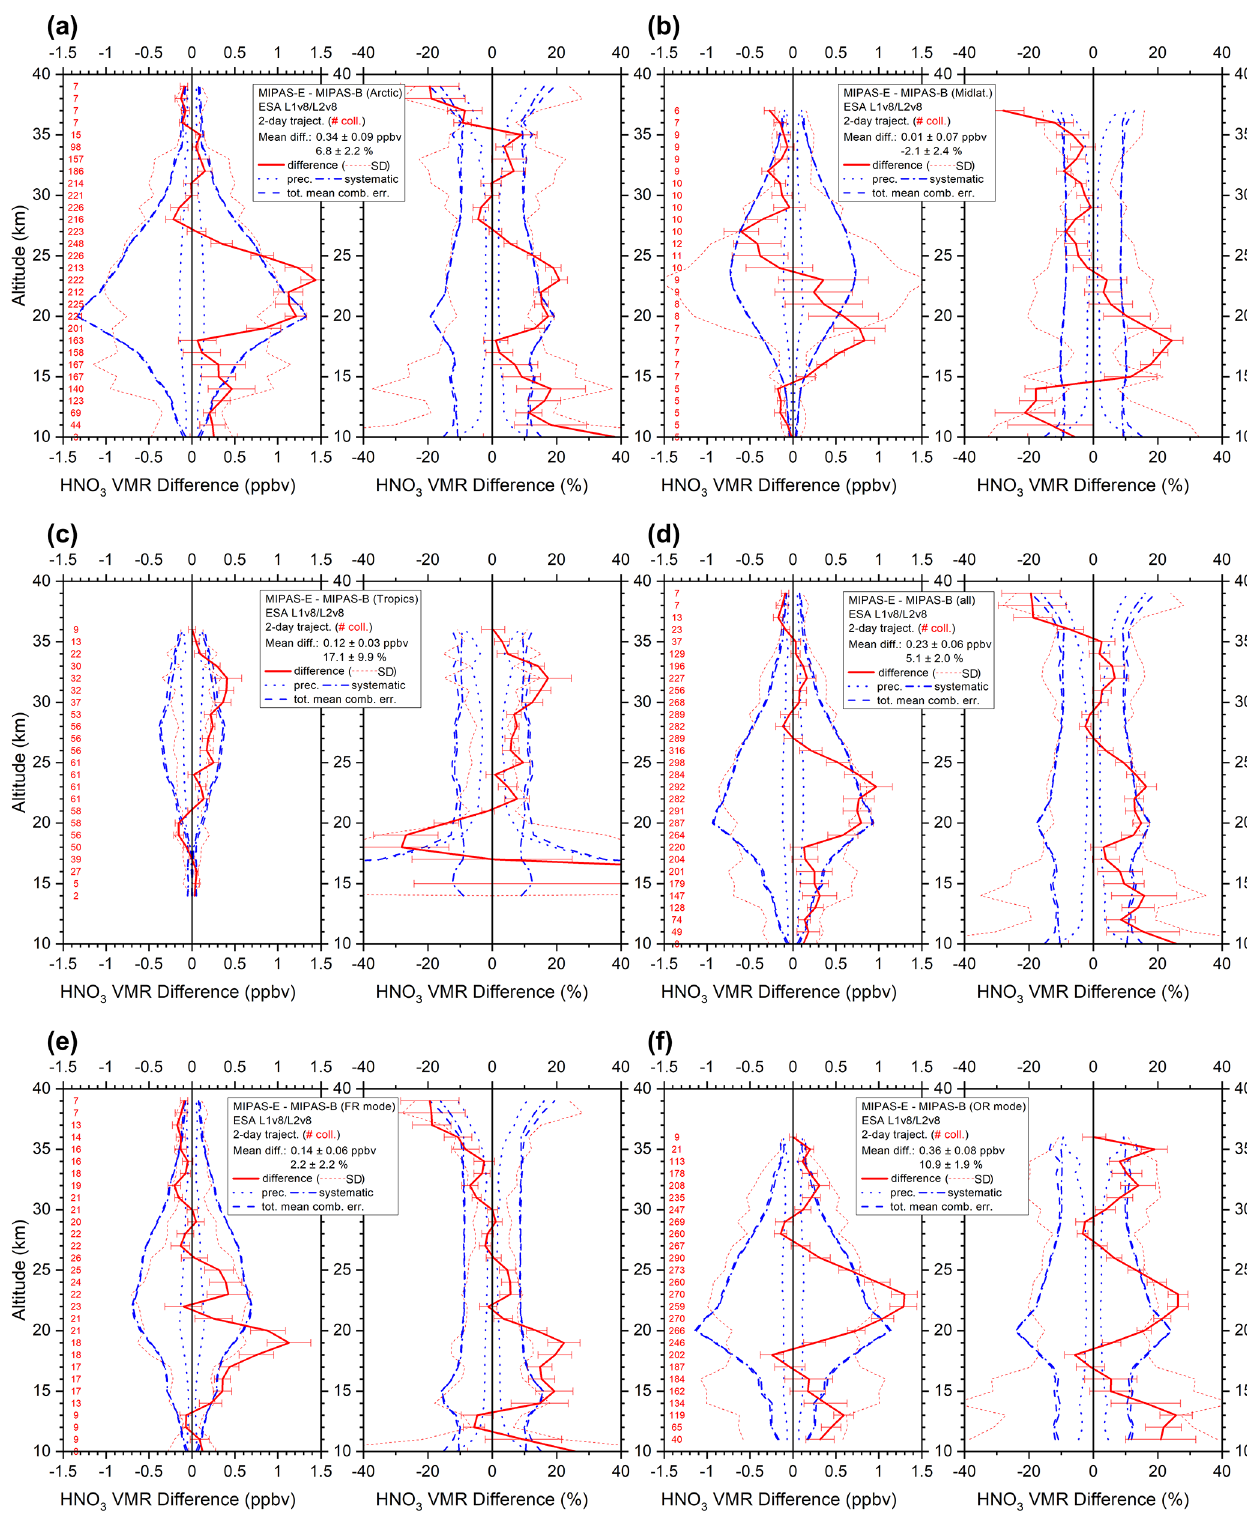
Figure 5. Same as Fig. 3 but for HNO 3